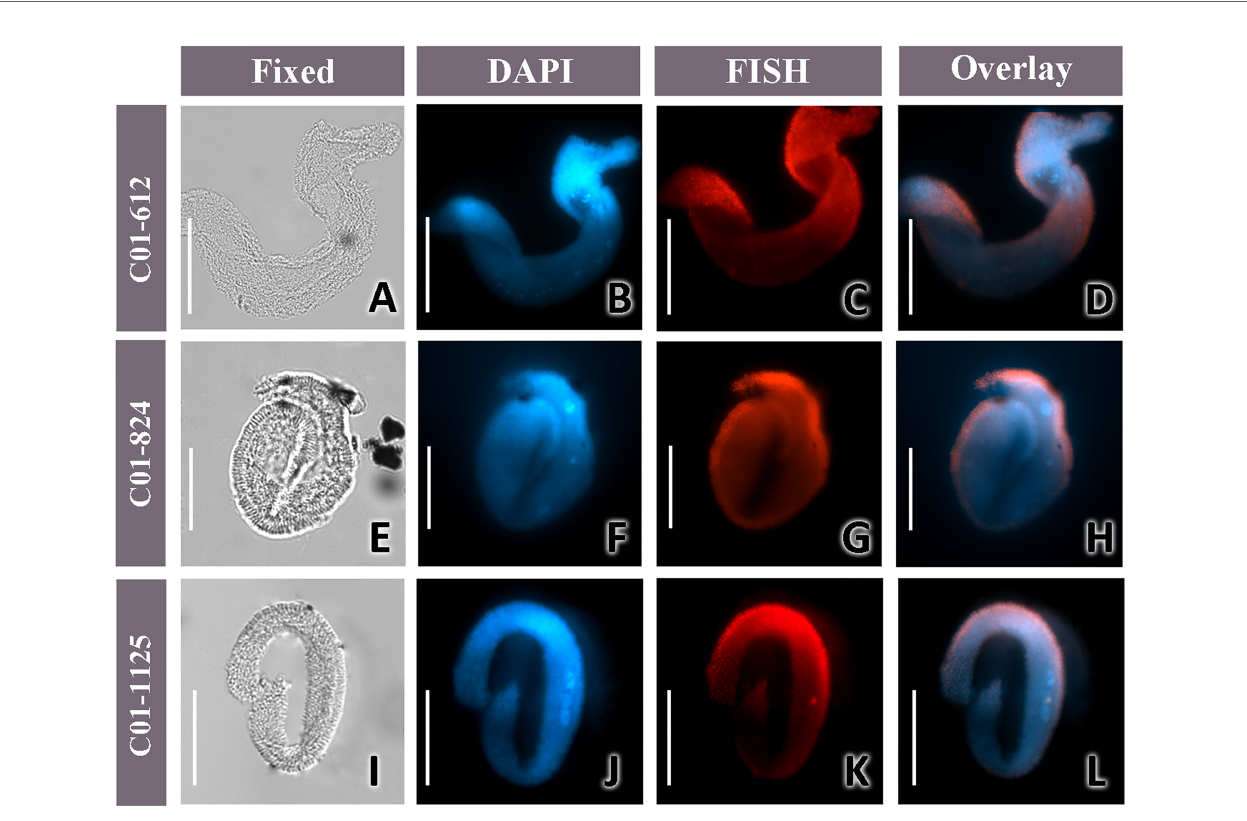
FIGURE 7 | Micrographs of K. fl avus with MLAKF. (A, E, I) Microphotographs of the fi xed cells in the bright fi eld; (B, F, J) DAPI staining; (C, G, K ), and fl uorescence in situ hybridization (FISH) using Cy3-C01-612 (C) , Cy3-C01-824 (G) , and Cy3-C01-1125 probes (K) ; (D, H, L) overlay of the DAPI and FISH. Scale bars = 50 m m (A – L) . The result for C01-824 was derived from a double-label experiment with a probe solution of 3.5 m l of Cy3-C01-824 plus 0.5 m l of AF488- chrCa, while others were generated from a single-probe (4- m l probe solution)